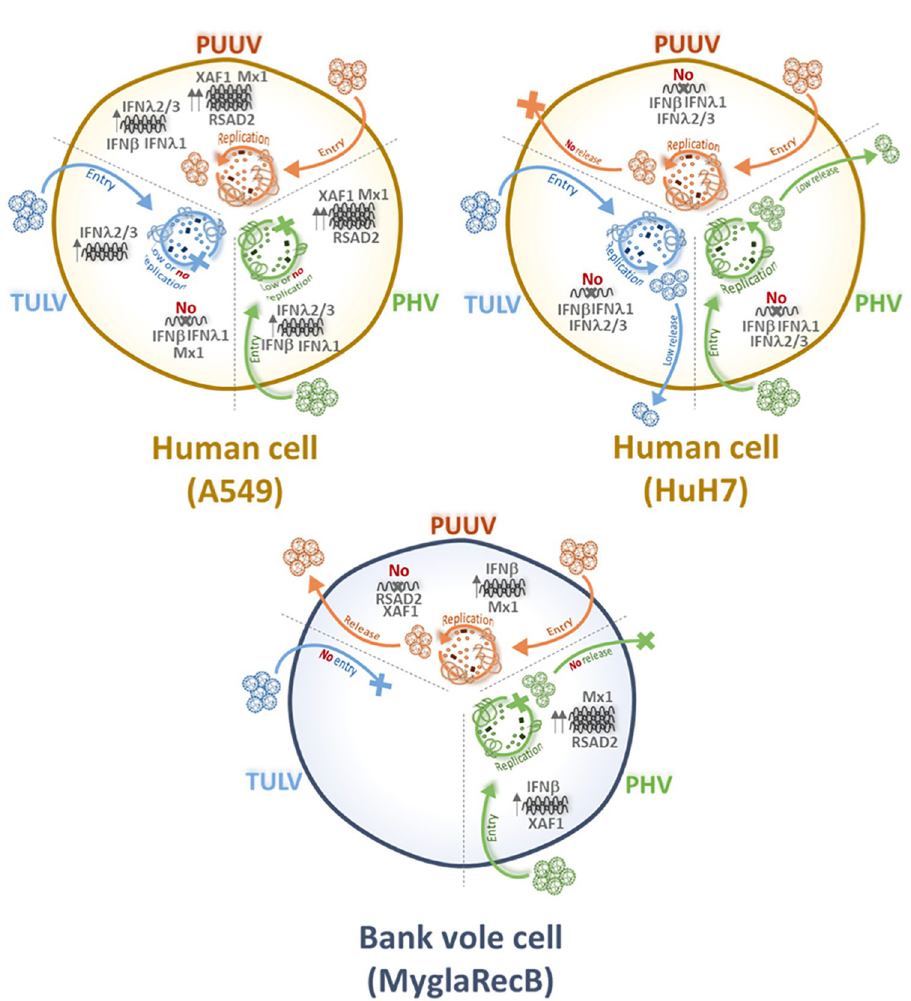
Fig 11. Schematic representation of the different interactions of orthohantaviruses with human and rodent cells. The cell susceptibility to PUUV- (orange), TULV- (blue) and PHV- (green) infection, viral replication and production of infectious particles in human A549 and HuH7 cells and bank vole MyglaSWRecB cells, are schematically summarized. Colored arrows, as indicated for each of the three viruses, indicate the main steps of the viral cycle i.e. entry, replication and release. Levels of expression of IFNs and ISGs are visualized as black RNA strands and their relative amount by grey arrows next to their